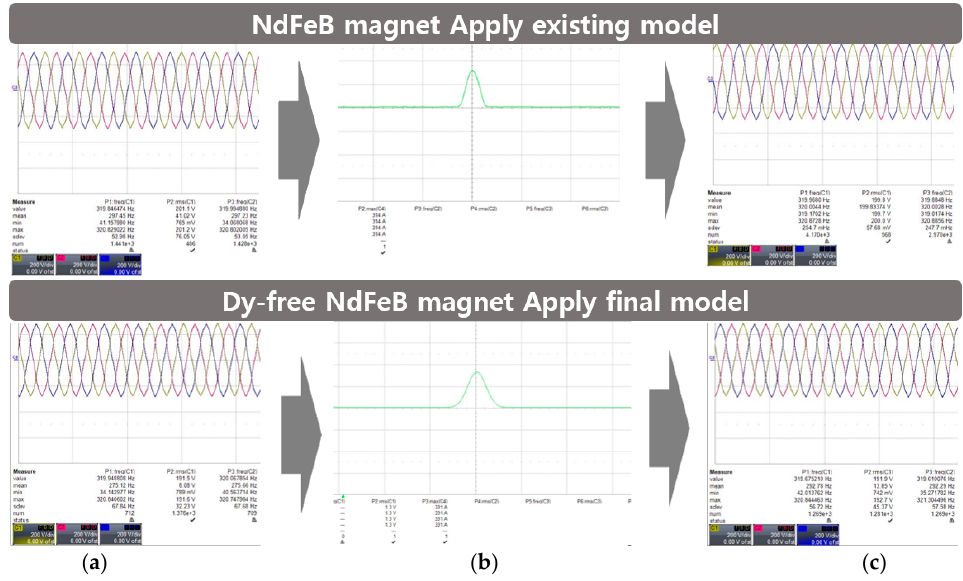
Figure 26. Waveform for conventional and proposed models: ( a ) Back-EMF waveform before applying the diamagnetic current, ( b ) Diamagnetic current waveform, ( c ) Back EMF waveform after applying the diamagnetic current. Table 4. Comparison of FEM simulation results and manufacturing experiment results.